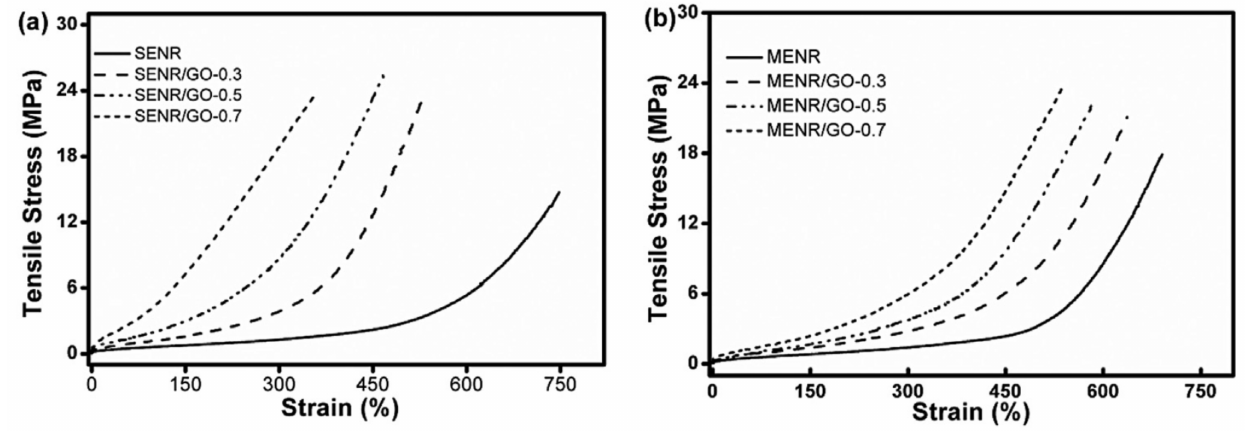
Figure 37. Representative stress-strain behavior for: ( a ) SENR/GO, and; ( b ) MENR/GO nanocomposites